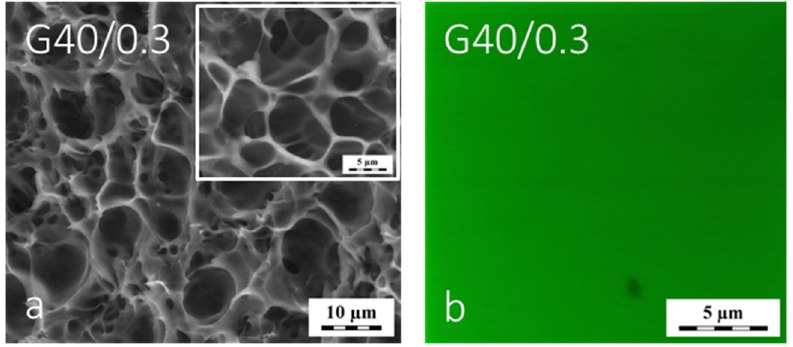
Figure 4. Cryo-SEM micrograph ( a ) and LSCM micrograph ( b ) of the water-swollen G40/0.3